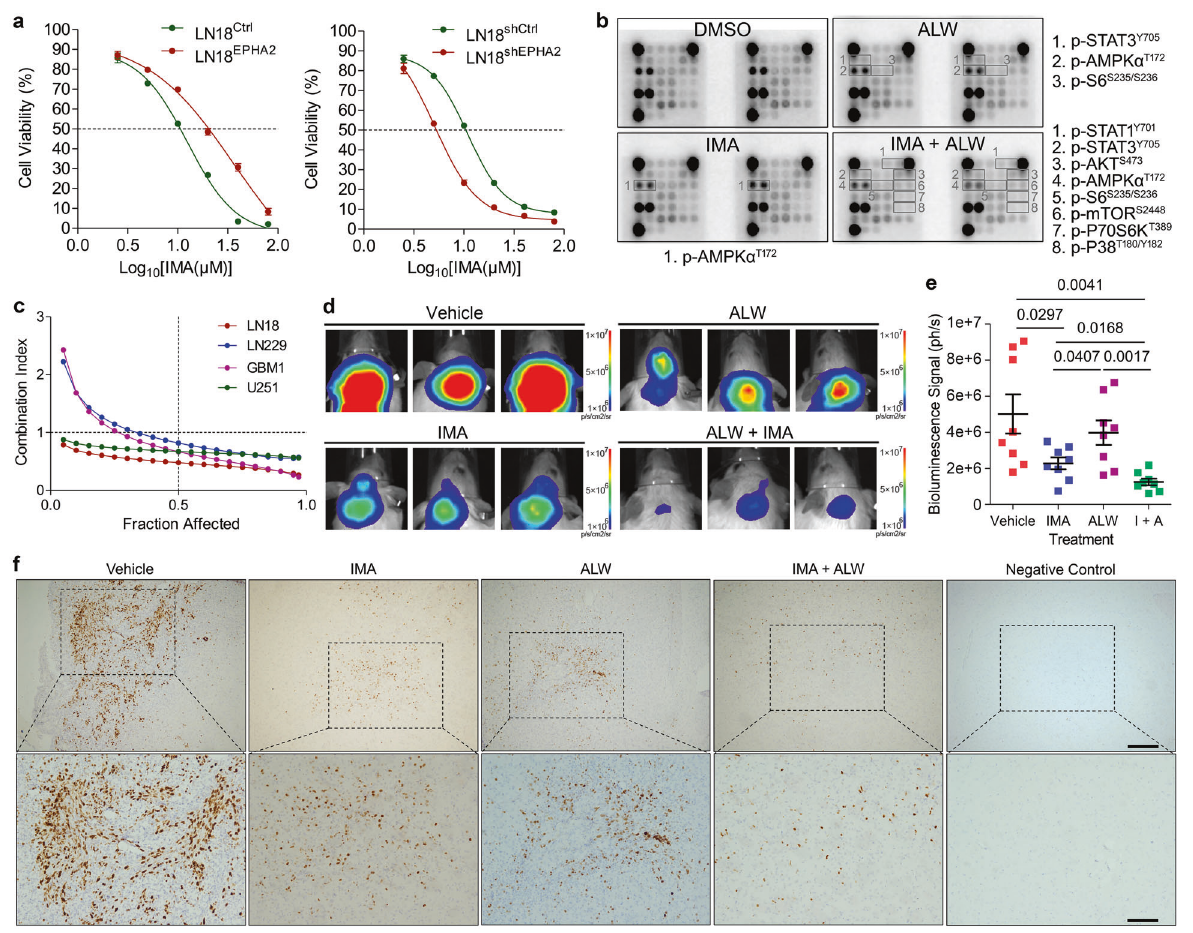
Fig. 6 Co-inhibition of PDGFRA and EPHA2 synergetically inhibits GBM cells. a IC 50 measurement of LN18 cells with forced expression of EPHA2 (left panel) or knockdown of EPHA2 (right panel) through MTT assay. b Antibody array analysis of LN18 cells treated with vehicle, EPHA2 inhibitor (ALW), and PDGFRA inhibitor (IMA). Signi fi cant changed proteins are labeled with frame and listed separately. c MTT assay- based drug combination evaluation in four GBM cell lines. d Representative images of orthotopic growth of U251 cells treated with vehicle, IMA, ALW, or IMA + ALW. e Statistic graph of tumor size using bioluminescence signal intensity. n = 8 for each group. f Representative immunohistochemistry images of Ki67 on tissue sections from mice with orthotopic GBM tumors treated by vehicle, IMA, ALW, or IMA + ALW. Scale Bar = 200 μ m (upper) and 100 μ m